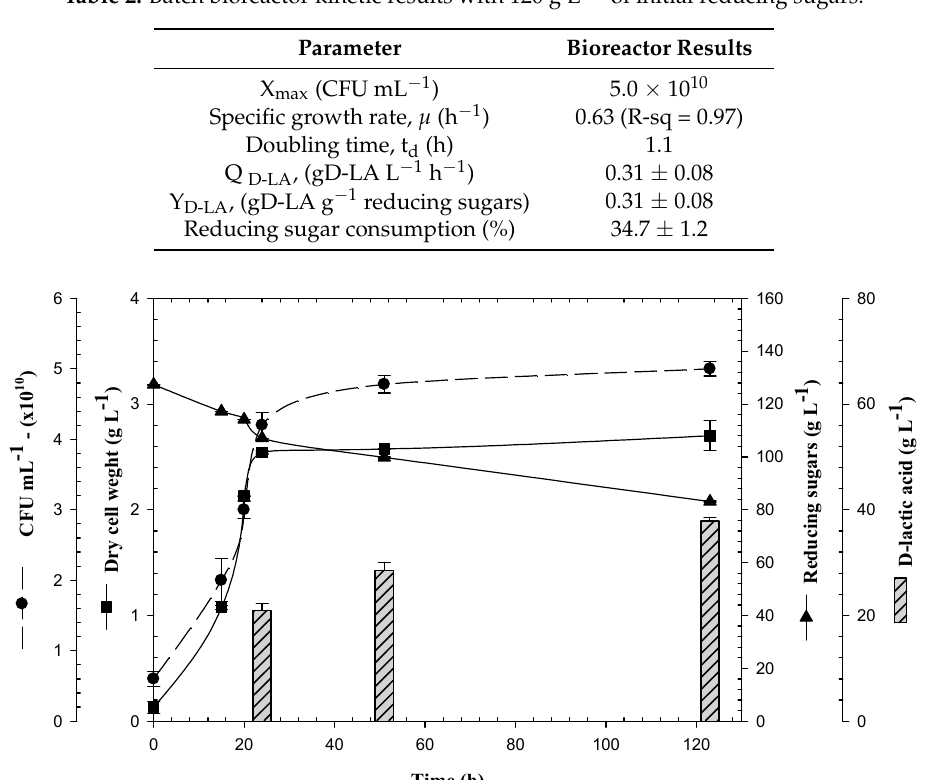
Figure 1. Kinetic of Escherichia coli JU15 in batch fermentations at 120 g L − 1 initial reducing sugars, 200 rpm, 37 ◦ C, and pH 6.6. Data from two independent experiments are